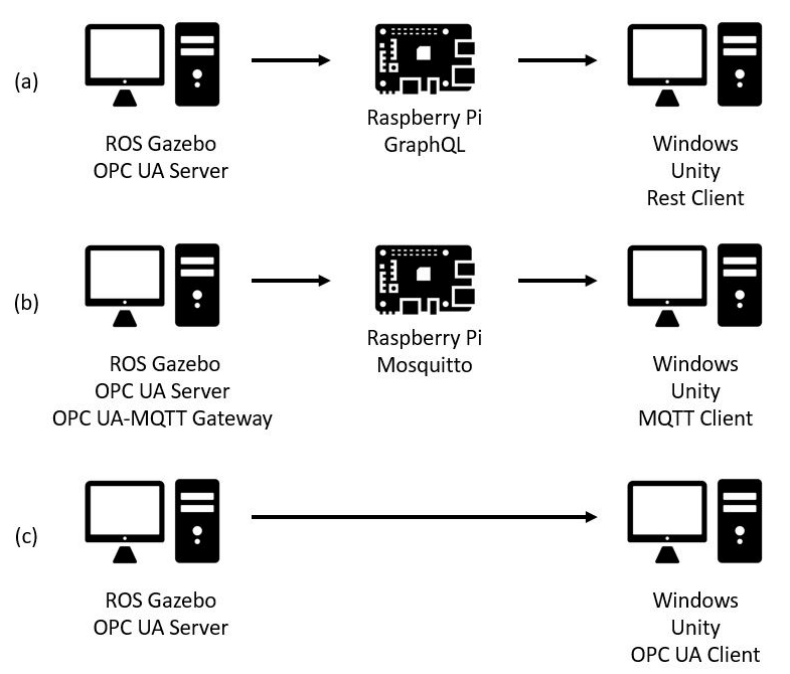
Figure 8. The process for the responsiveness test leveraging different communication middleware: ( a ) Responsiveness test for the OPC UA-GraphQL wrapper. ( b ) Responsiveness test for the OPC UA-MQTT wrapper. ( c ) Responsiveness test for the OPC UA Client in